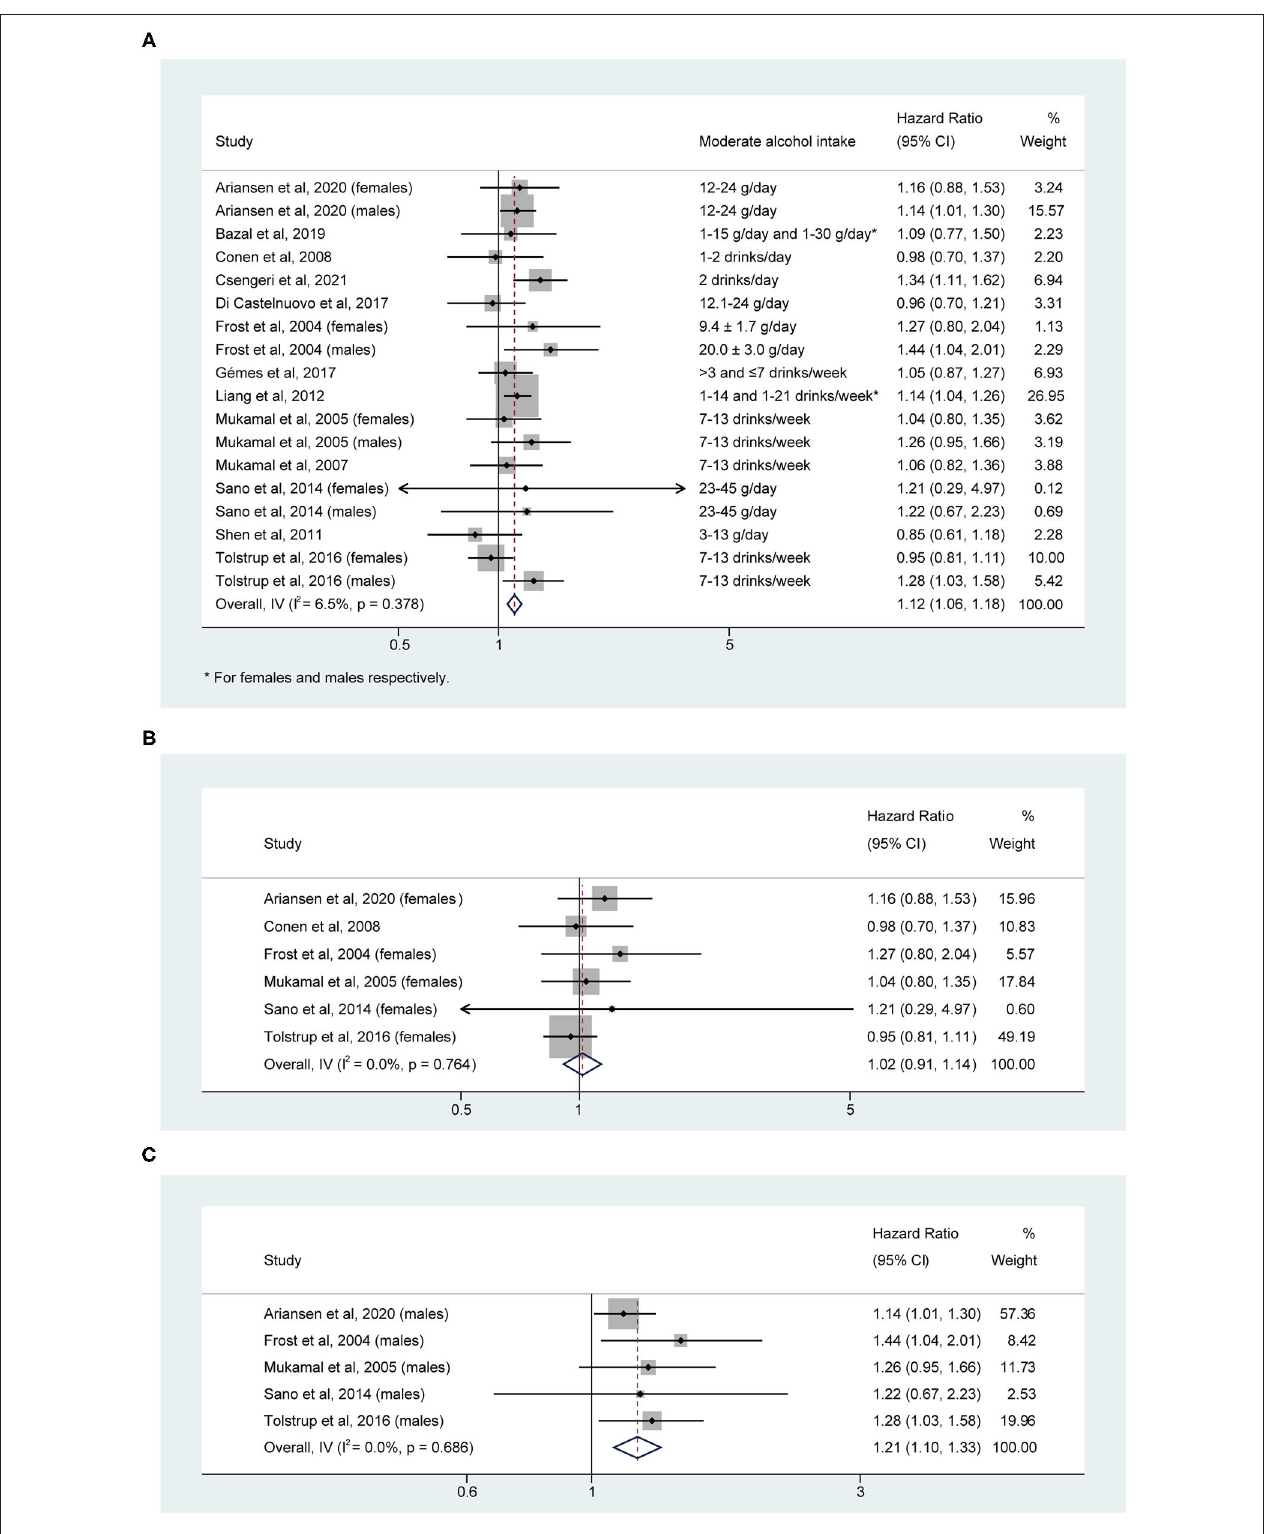
FIGURE 3 | Hazard ratios of risk of atrial fibrillation for moderate alcohol intake in (A) overall, (B) female, and (C) male individuals.